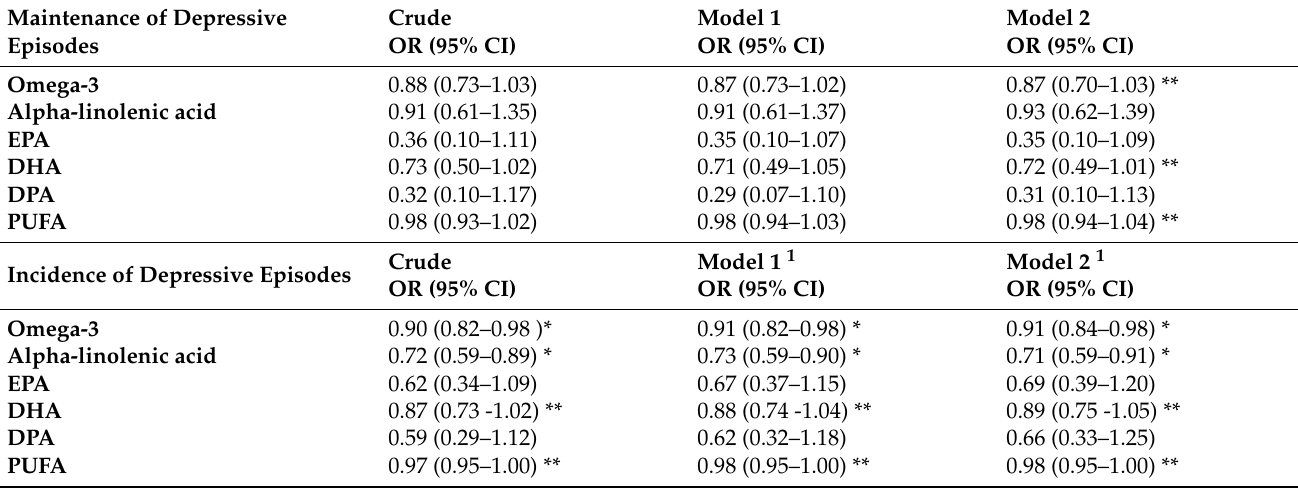
Table 3. Odds ratios (OR) and confidence intervals for associations between maintenance of depres- sive episodes, incidence of depression, and consumption of omega-3, alpha-linolenic acid, polyunsat- urated fats (PUFA), eicosapentaenoic acid (EPA), docosahexaenoic acid (DHA), and docosapentaenoic acid (DPA) with the estimates from models 2 and 3. ELSA-Brasil Study 2008–2010 (baseline) and 2012–2014 (first follow-up visit).